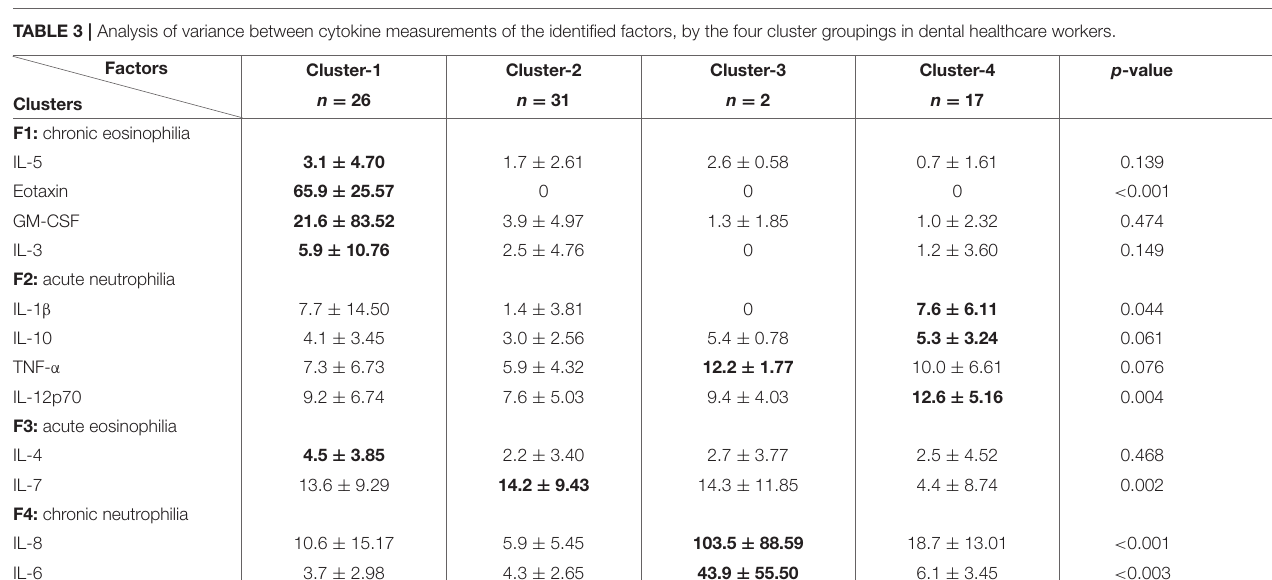
TABLE 3 | Analysis of variance between cytokine measurements of the identified factors, by the four cluster groupings in dental healthcare workers.